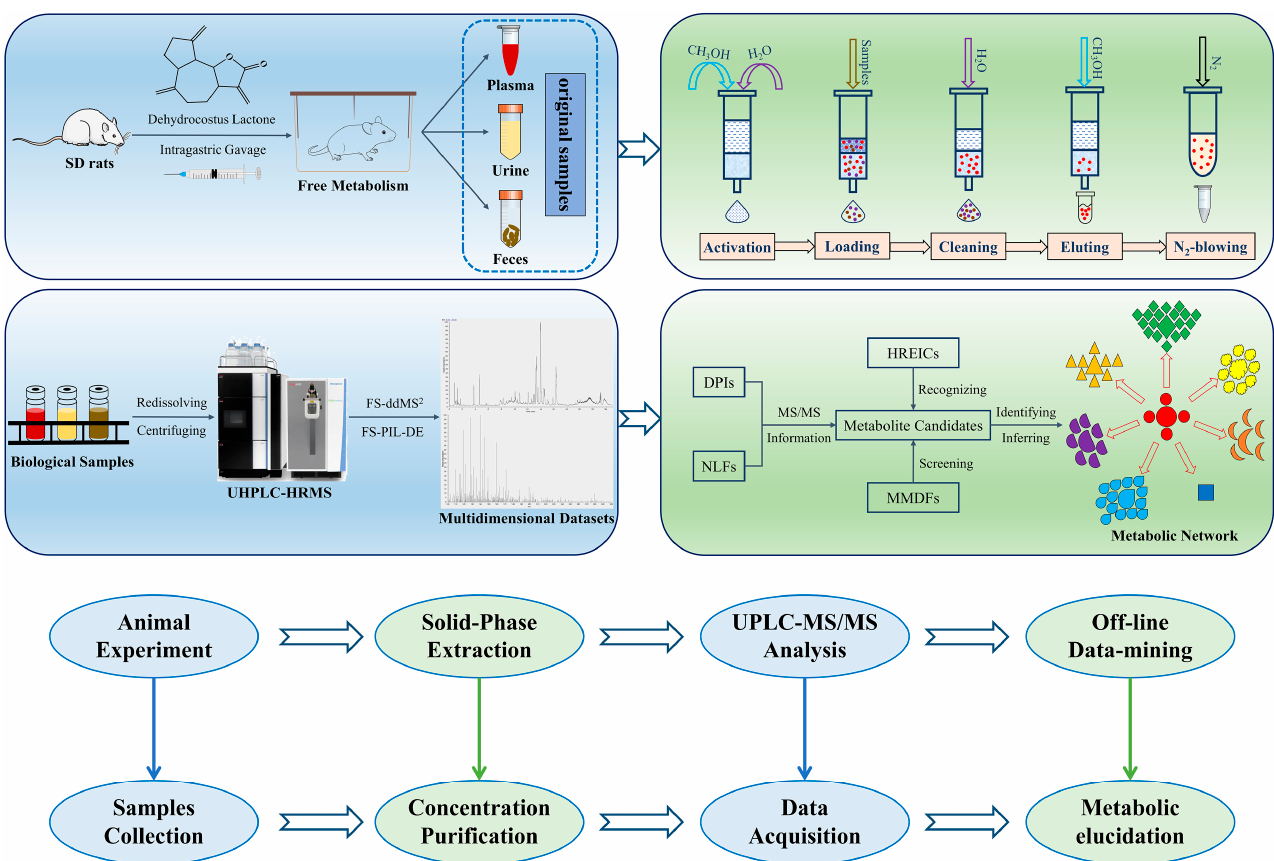
Figure 2. Schematic representation of analytical strategy and workflow.